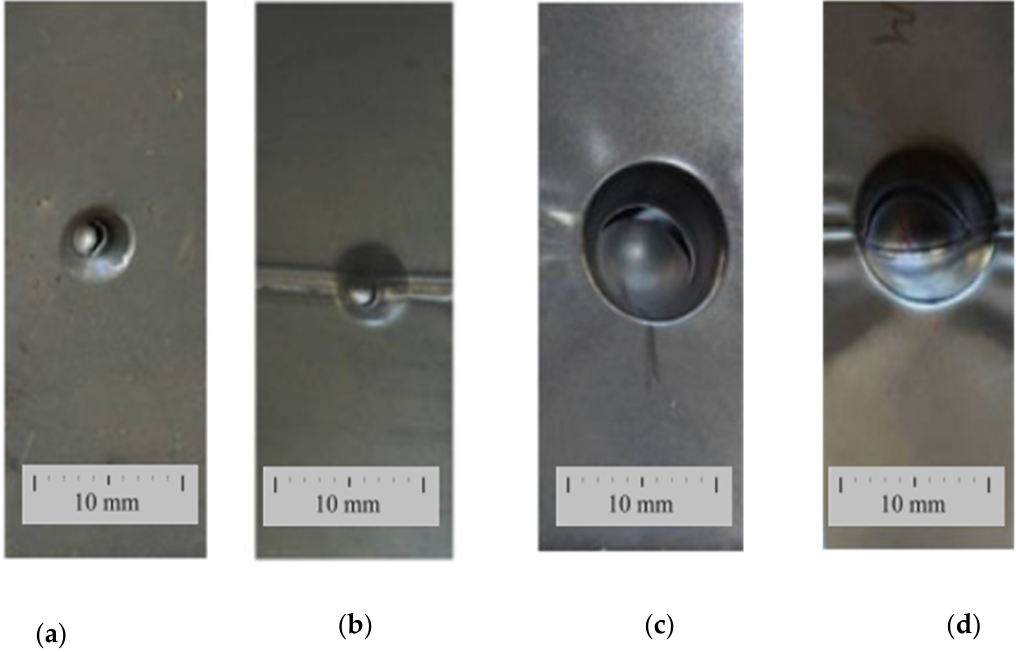
Figure 7. The appearance of samples after the Erikson test: ( a ) base metal, ( b ) weld, punch diameter – 3 mm; ( c ) base metal, ( d ) weld, punch diameter – 8 mm; ×2.